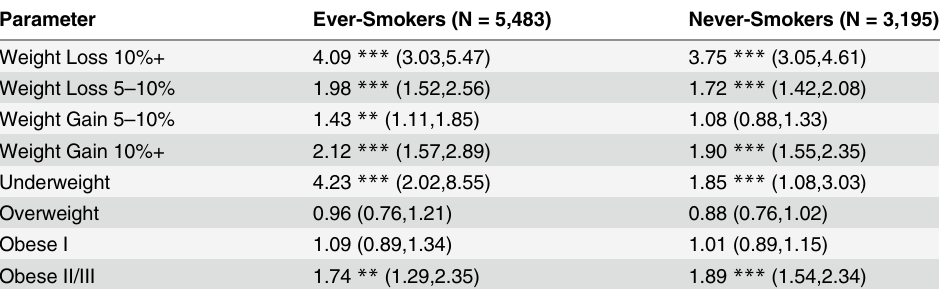
Table 4. Adjusted Effects of Baseline BMI and Weight Change Over Time on Mortality (Marginal Struc- tural Models by Smoking Status).